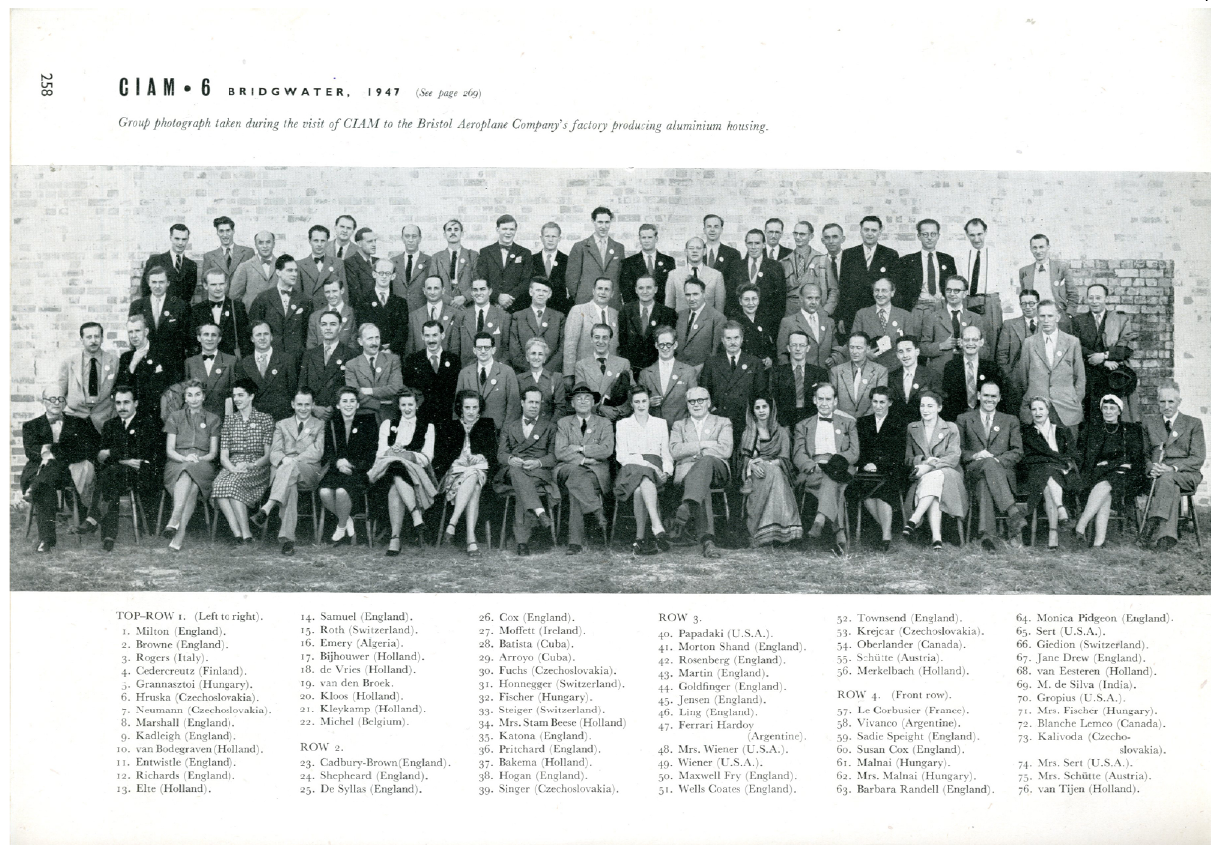
CIAM 6 group photograph as published in Architectural Design , October 1947,